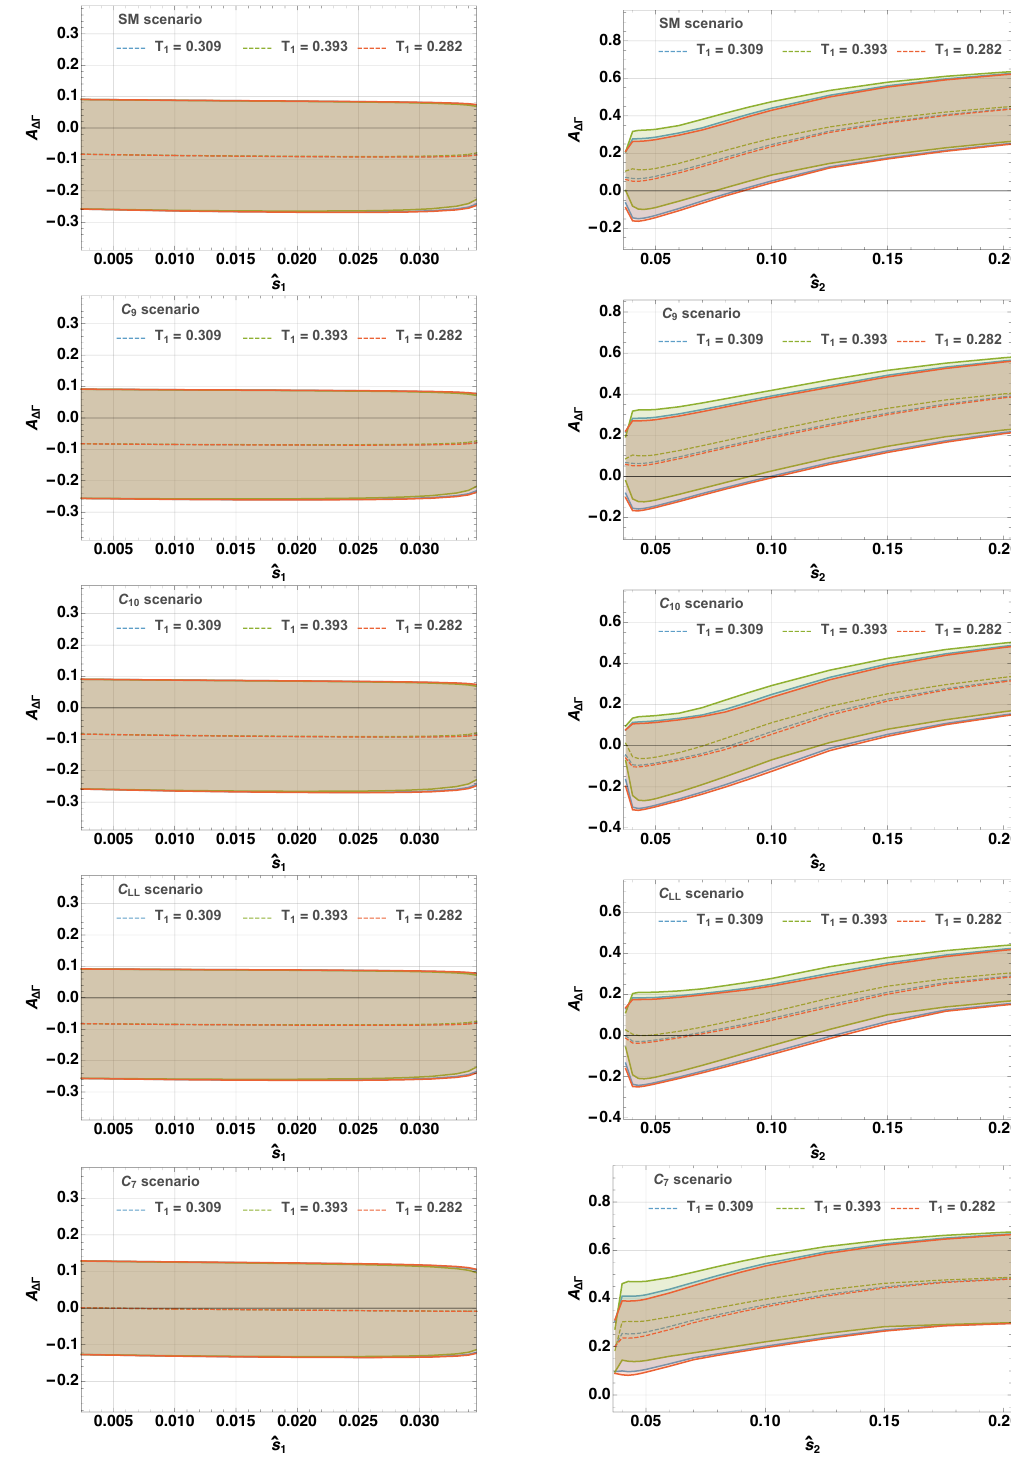
prediction, integrated in the interval [4 m 2 Figure 2 . A µµγ ∆Γ s panels), within the scenarios indicated. We use JPZ f.f.’s [33] as well as three choices of T ¯ B 0 s → φ see below eq.